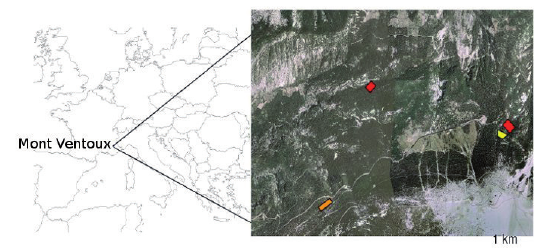
Fig.1. Localization of Mont Ventoux at the European scale and localization of the stands analyzed within Mont Ventoux: high density mature stands HD1 and HD2 (in red), medium density peripheral stand MD (in orange) and low density recolonizing stand LD (in